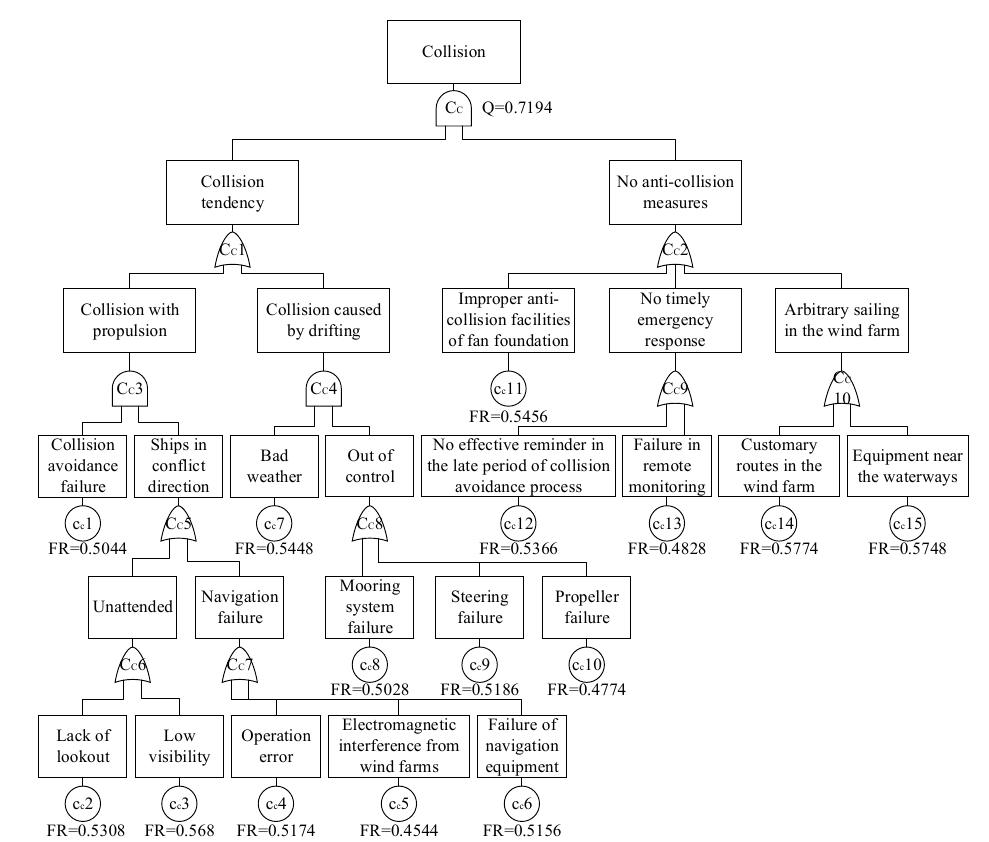
Figure 14. Fault tree analysis model for collision risk of the offshore wind farm.